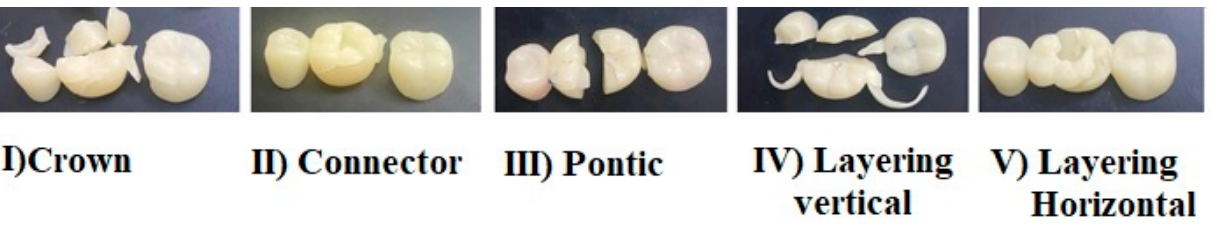
Figure 7. Representative photos displaying the type and position of different fractures .